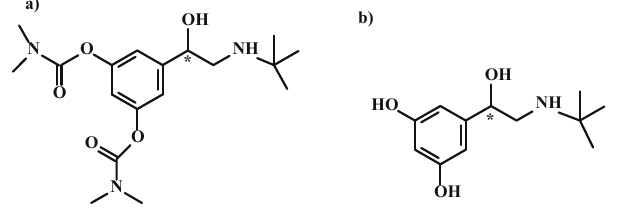
Figure 9: Structures of ( a ) bambuterol and its active form ( b )